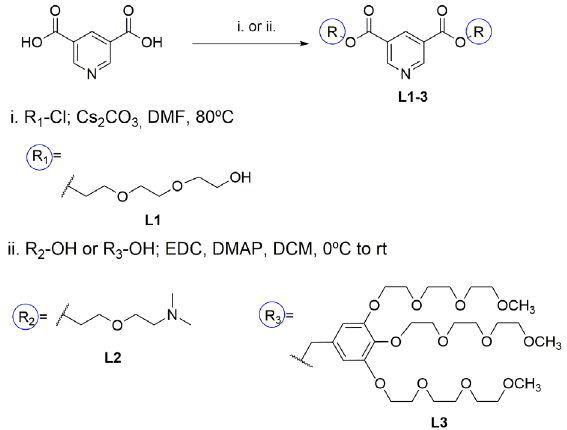
Figure 26 - Synthesis of ligands L1 - 3